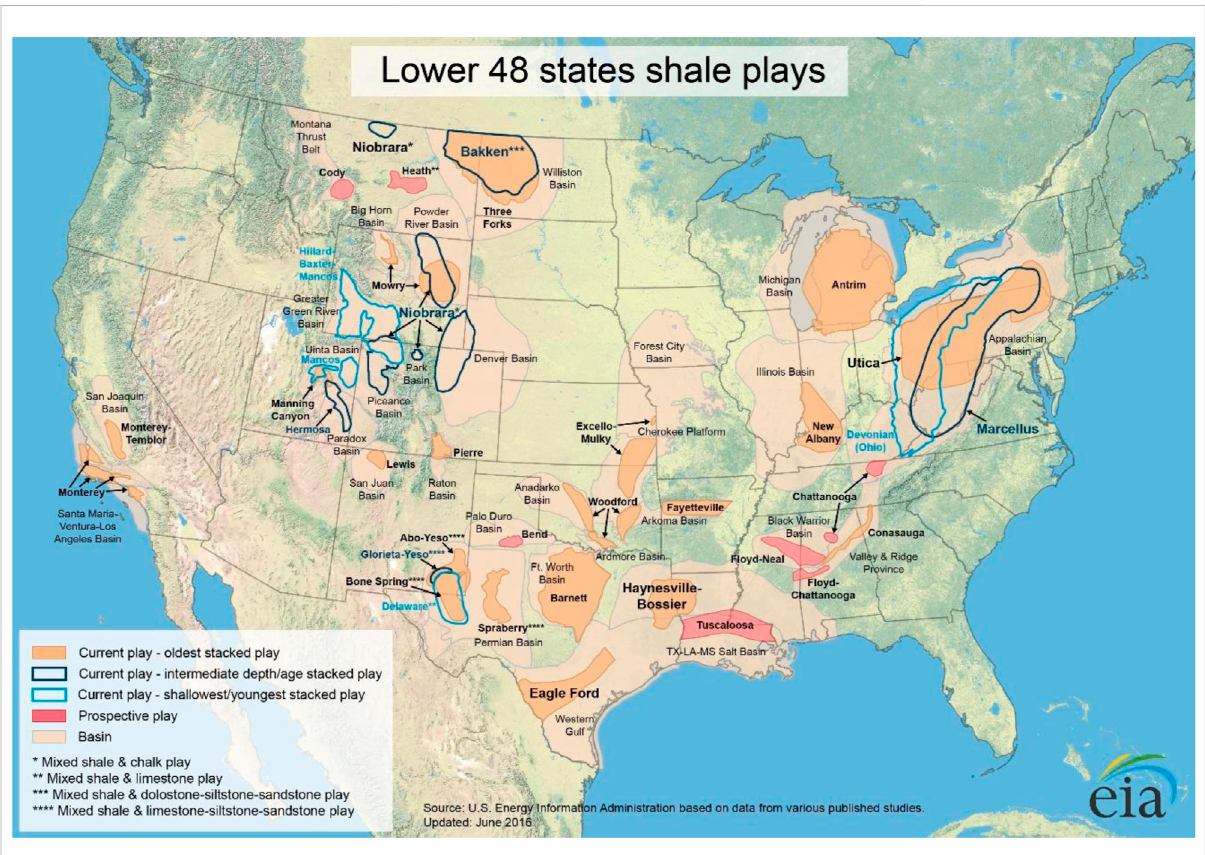
FIGURE 1 The U.S. lower 48 states shale oil and natural gas maps [source: U.S. Energy Information Administration (June